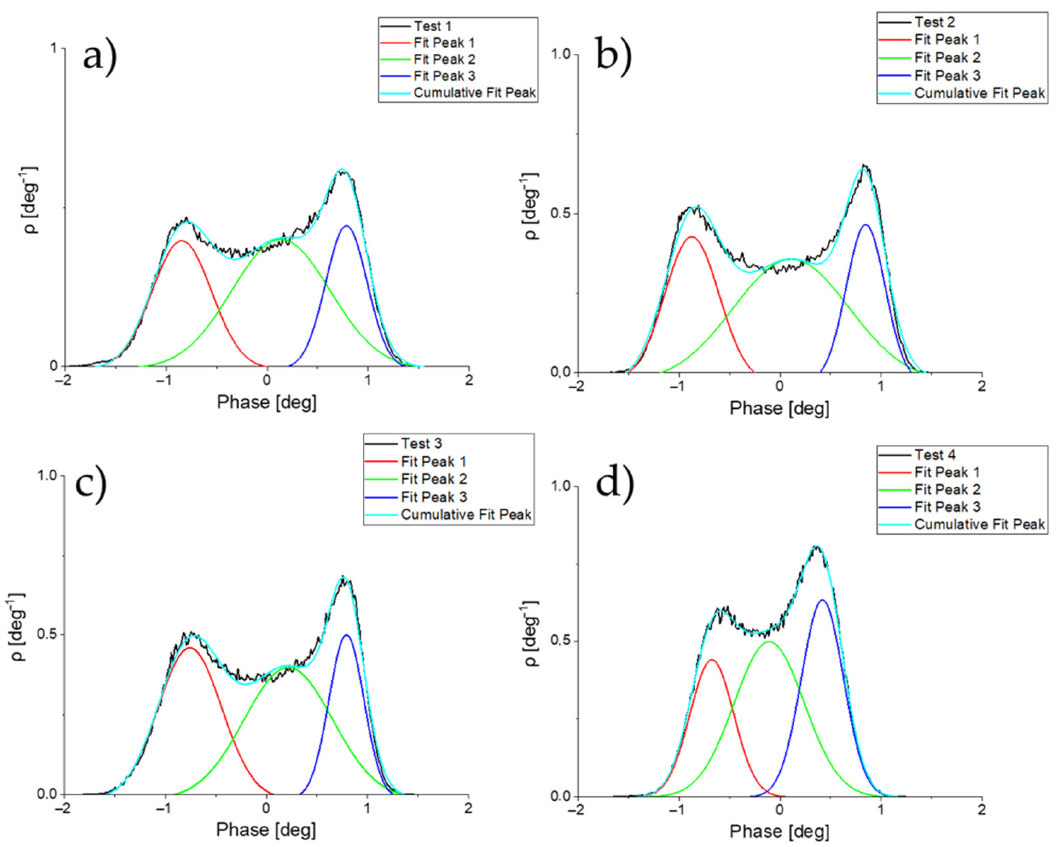
Figure 4. Representation of the computational extraction of the height distribution function which represents the maximum and minimum MFM contrast obtained from the magnetic tip 10 at week 1 ( a ), 7 ( b ), 13 ( c ), and 21 ( d ). The blue and red curves represent the maximum and minimum phase values.